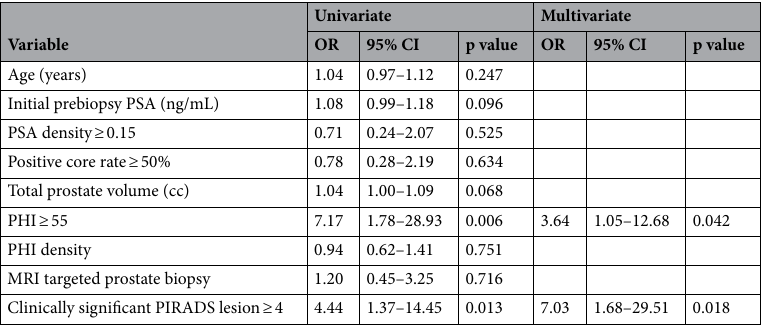
Table 2. Logistic regression analysis for predicting Gleason score upgrading at RP. OR odds ratio, CI confidence interval, PSA prostate specific antigen, PHI prostate health index, MRI magnetic resonance imaging, PIRADS prostate imaging reporting and data system, ISUP GG International Society of Urological Pathology grade group.